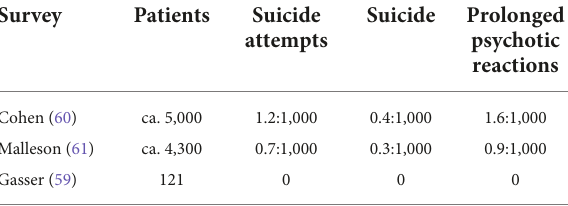
TABLE 4 Suicide attempts, suicide and prolonged psychotic reactions in psycholytic/psychedelic therapy.